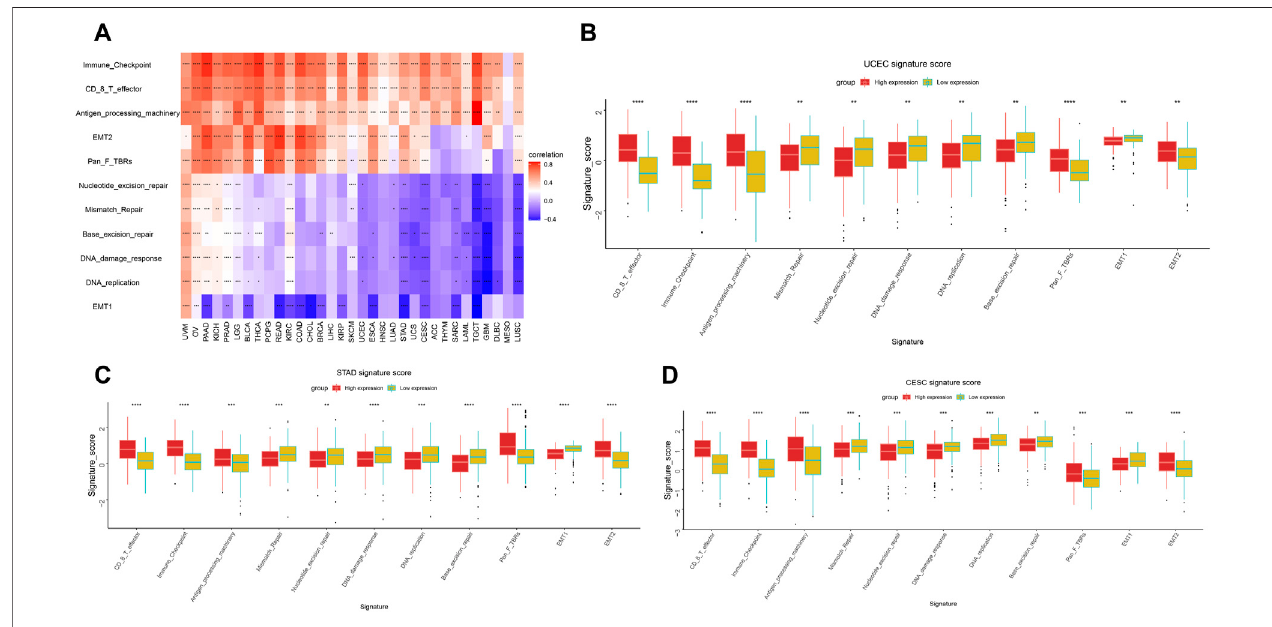
FIGURE10| CorrelationbetweenLY96expressionandtumormicroenvironment. CorrelationbetweenLY96expressionandimmune-relatedpathways (A) . (B – D) Different signature score between high and low LY96 expression in (B) uterine corpus endometrial carcinoma (UCEC), (C) stomach adenocarcinoma STAD, and (D) cervical squamous cell carcinoma and endocervical adenocarcinoma